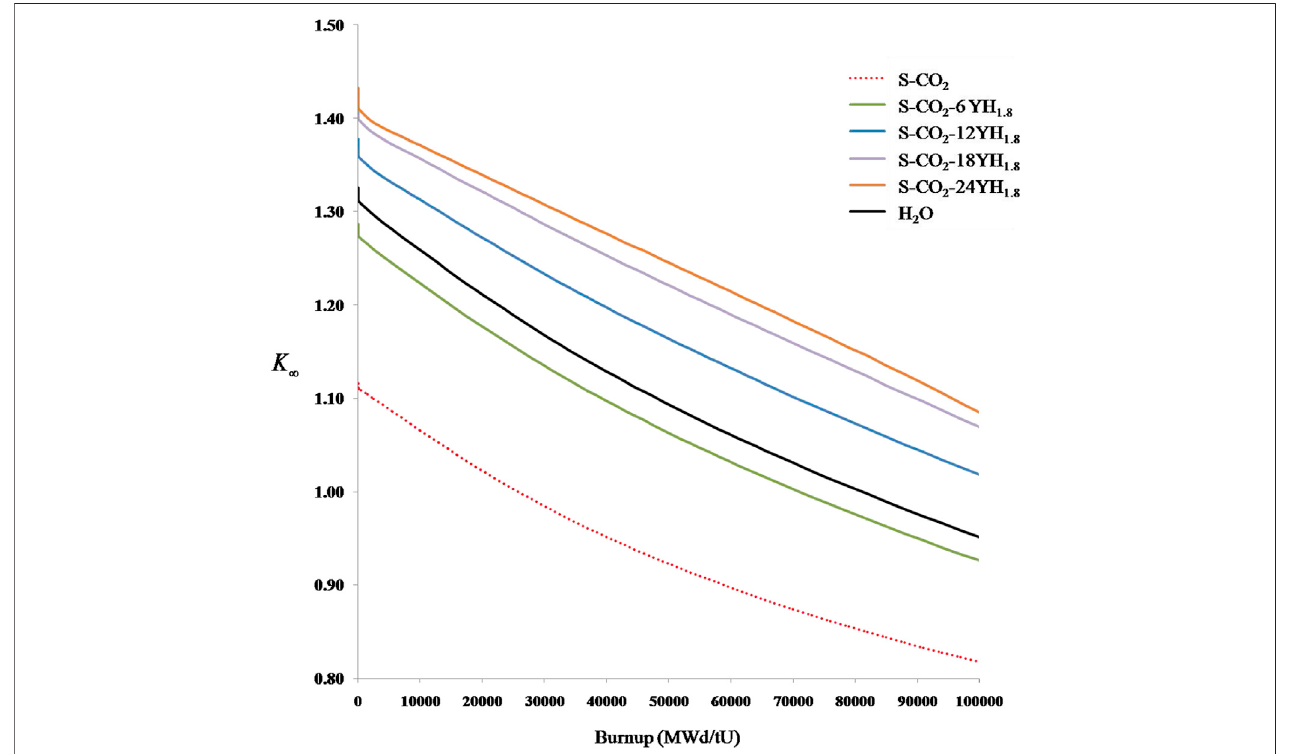
FIGURE 7 | K ∞ by different numbers of YH 1.8 rods versus burn up.